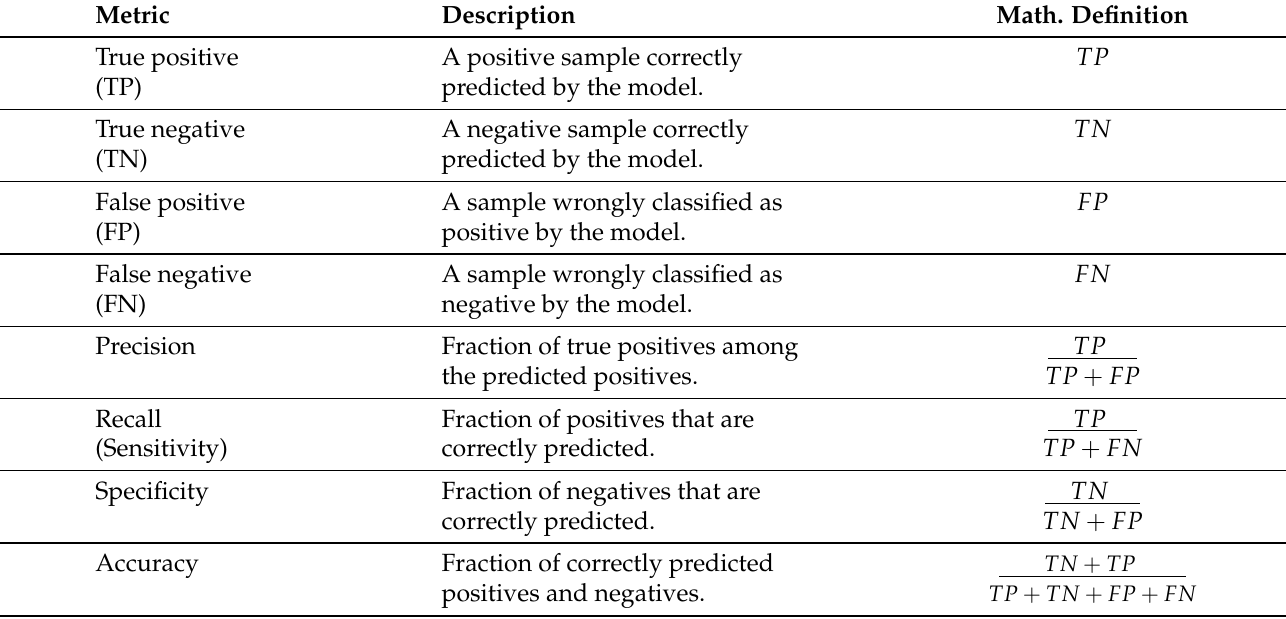
Table 5. Description of performance metrics. Here, a “positive” label can, for example, correspond to “having CVD”, while a “negative” may correspond to